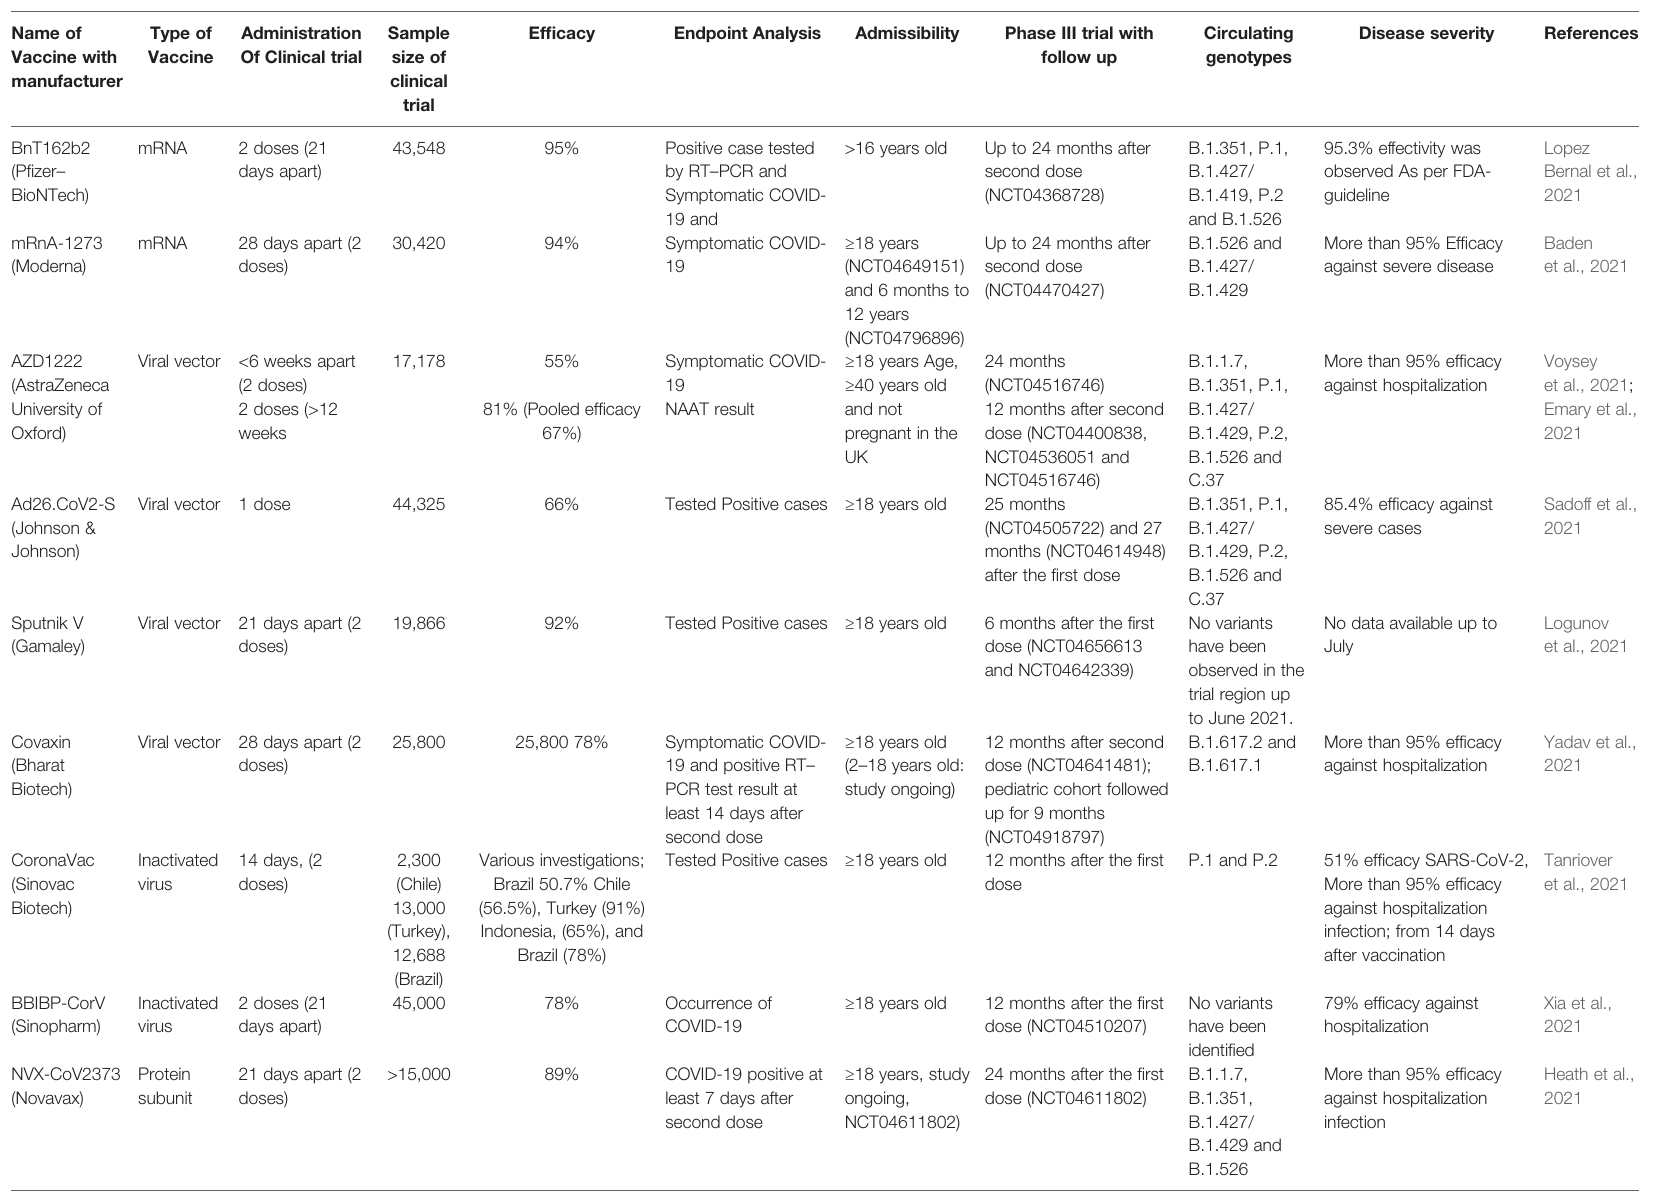
TABLE 2 | Ef fi cacy of SARS-CoV-2 vaccine and effectiveness on